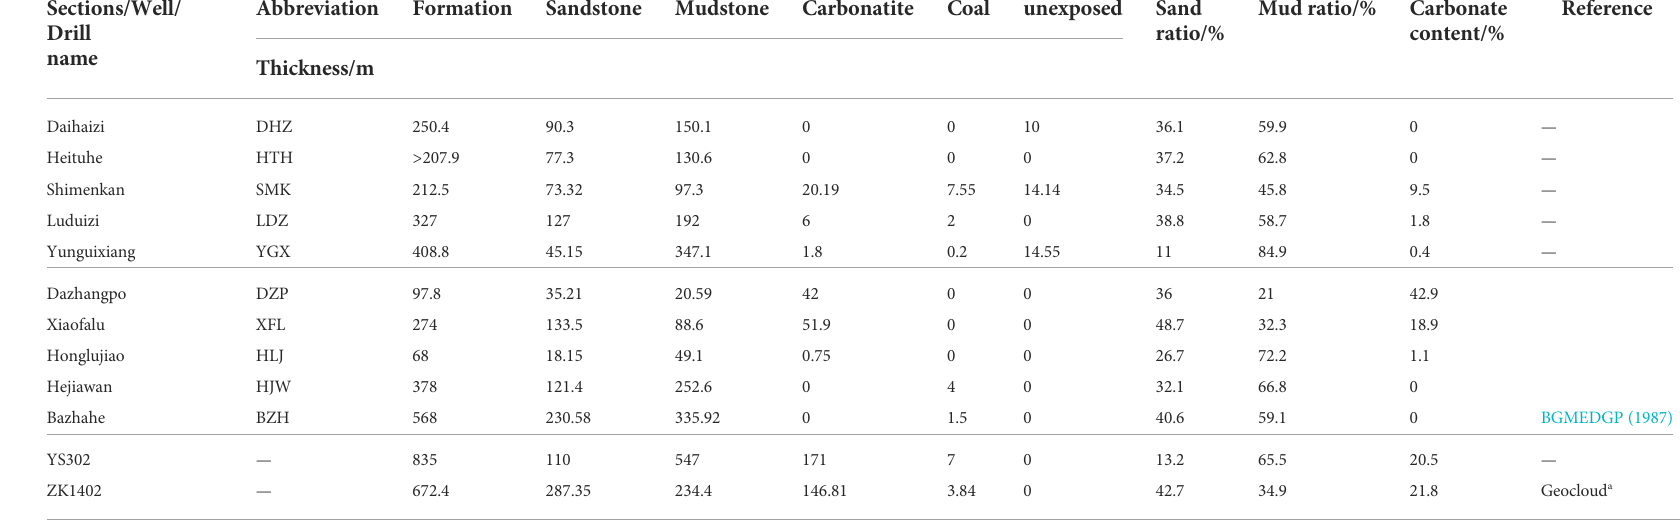
TABLE 1 Lithological dataset of the Jiusi Formation in northeastern Weining. Sections/Well/